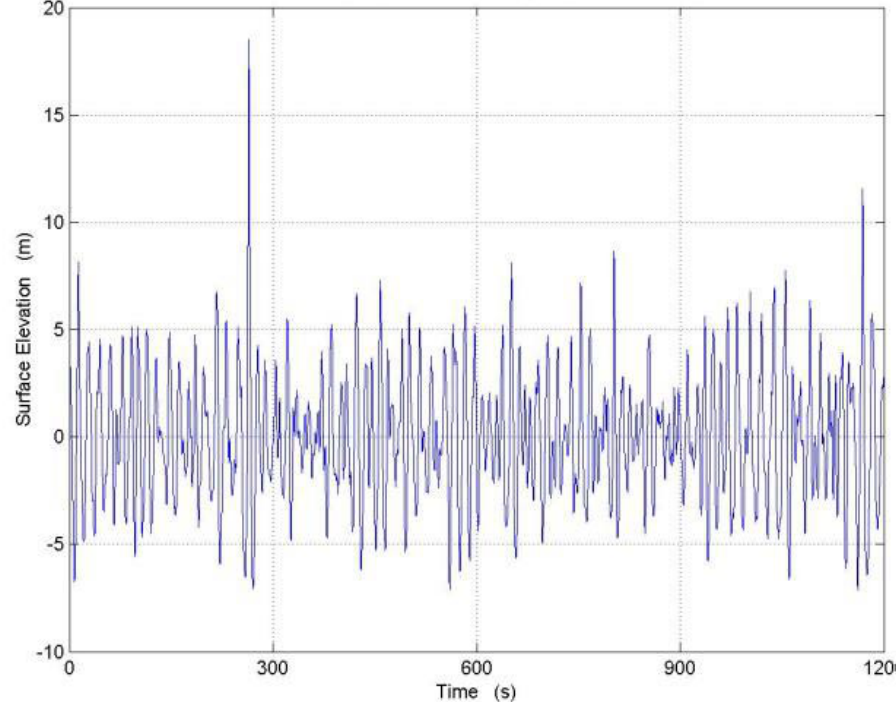
Fig. 1. The time series of a recognized freak wave recorded on 1995 New Year’s Day (1995) at the Draupner Platform in the Norwegian sector of the North Sea. The wave elevation was measured by a downward-looking radar system. Data courtesy of Sverre Haver of Statoil. Figure 1. The time series of a recognized freak waves recorded on 1995 New Years day at the Draupner Platform in the Norwegian sector of the Northe Sea. The wave elevation was measured by a downward looking radar system. Data courtesy of Sverre Haver of Statoil.